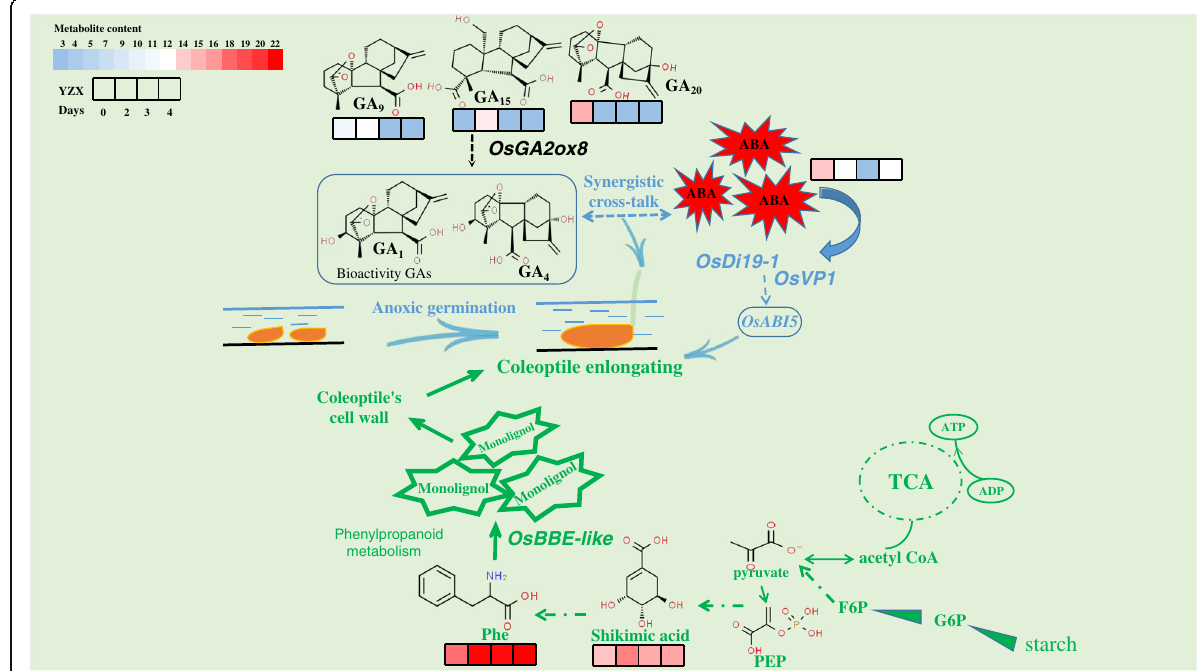
Fig. 9 Proposed mechanism of four candidate genes function in enhancing anaerobic germination. Abbreviations are as follows: G6P, Glucose-6- phosphate; F6P, Fructose-6-phosphate; PEP, phosphoenolpyruvic acid; Phe, phenylalanine; TCA, tricarboxylic acid